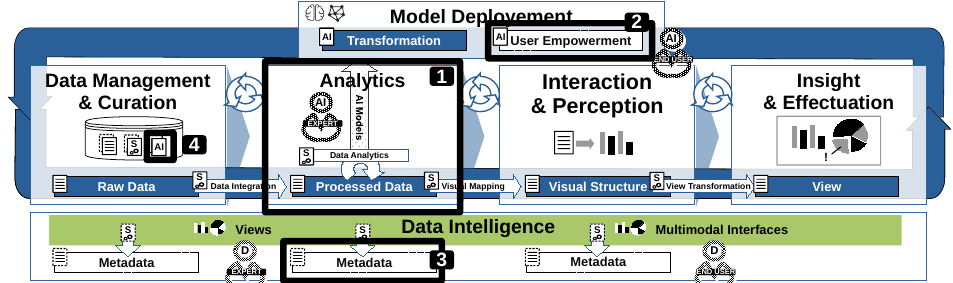
Figure 11. Conceptual model integration into AI2VIS4BigData Reference Modell, © 2022 IEEE. Reprinted, with permission, from Reis et al. [8].